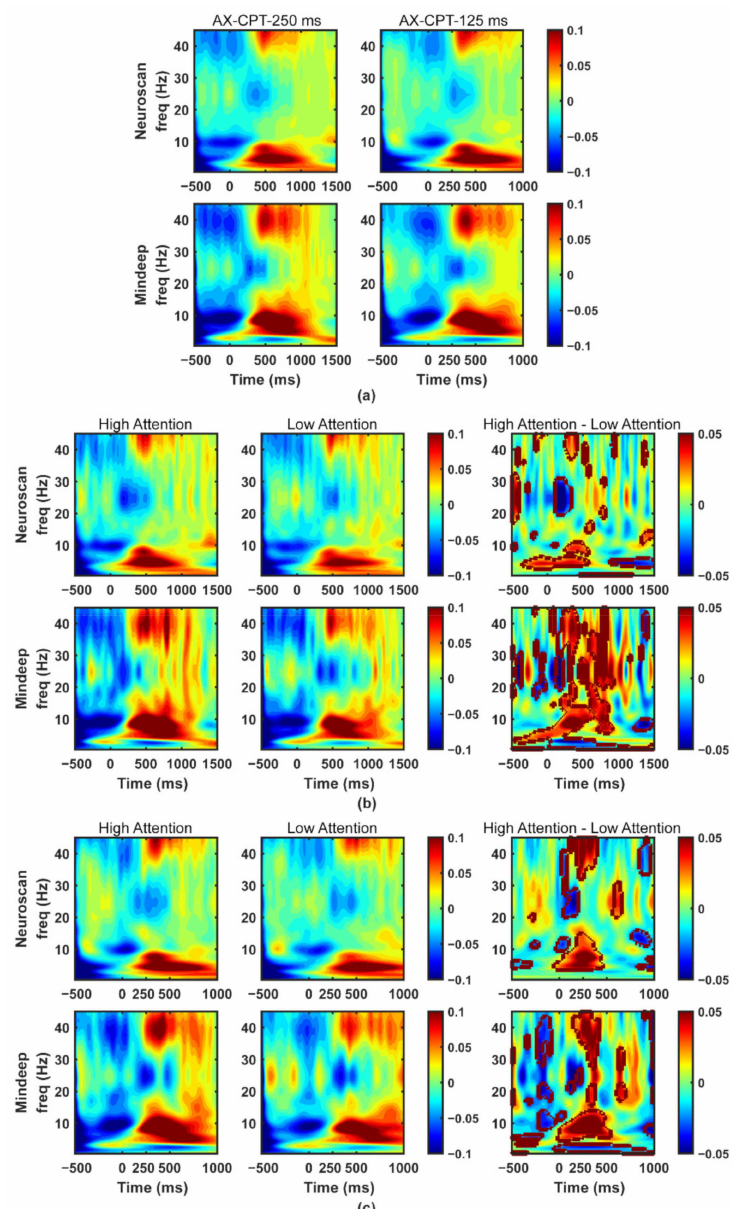
Figure 9. Time-frequency results of AX-CPT tasks. ( a ) Time-frequency analysis graphs of EEG simultaneously recorded by Neuroscan and Mindeep during attention task 1 and task 2. Time- frequency graphs for high attention and low attention, and the time-frequency differences between high attention and low attention for Neuroscan and Mindeep, respectively, during attention tasks